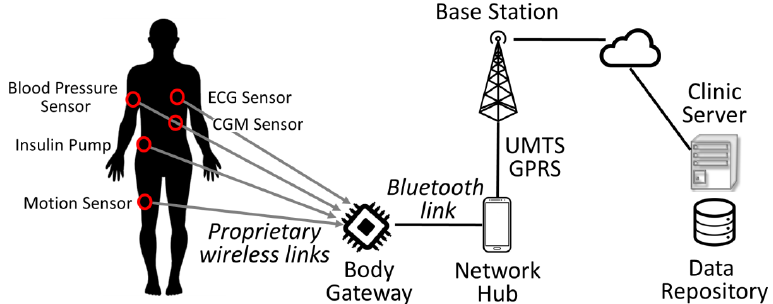
Fig. 2. The architecture adopted for a body area network sees multiple wearable devices, e.g., blood pressure, glucose, motion, ECG and CGM sensors and insulin pump that are coordinated by a Body Gateway. 24 The Body Gateway interacts using Bluetooth with the Network Hub that enacts remote monitoring. This ¯gure is reproduced from Lanzola et al. , 24 which is distributer under a Creative-Com- mons license (CC-BY). http://creativecommons.org/licenses/by/4.0/.